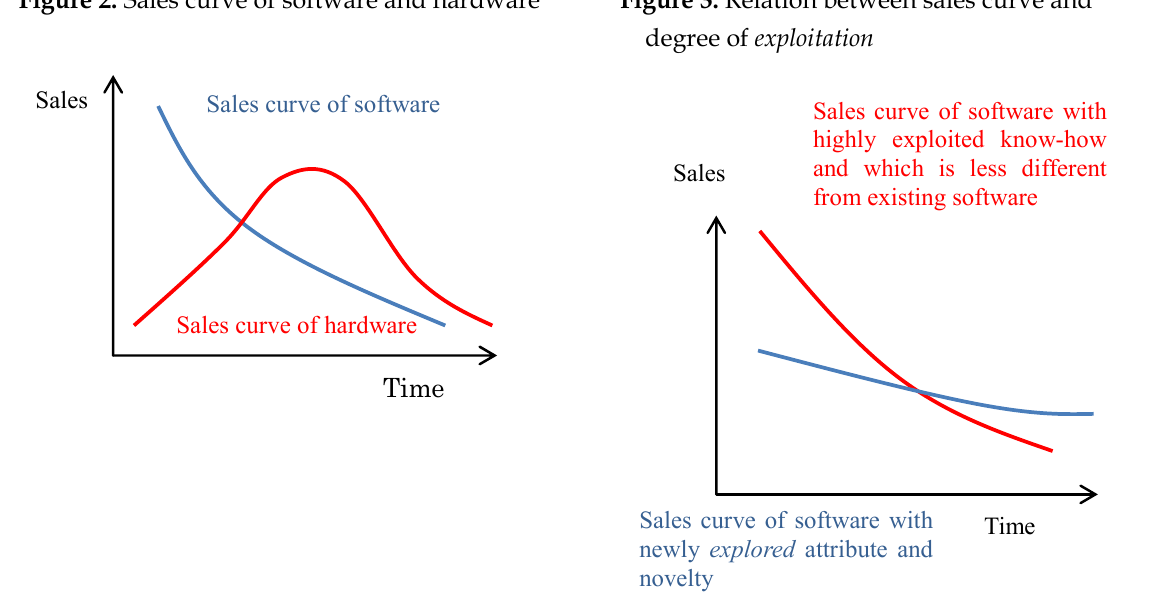
Figure 2. Sales curve of software and hardware Figure 3. Relation between sales curve